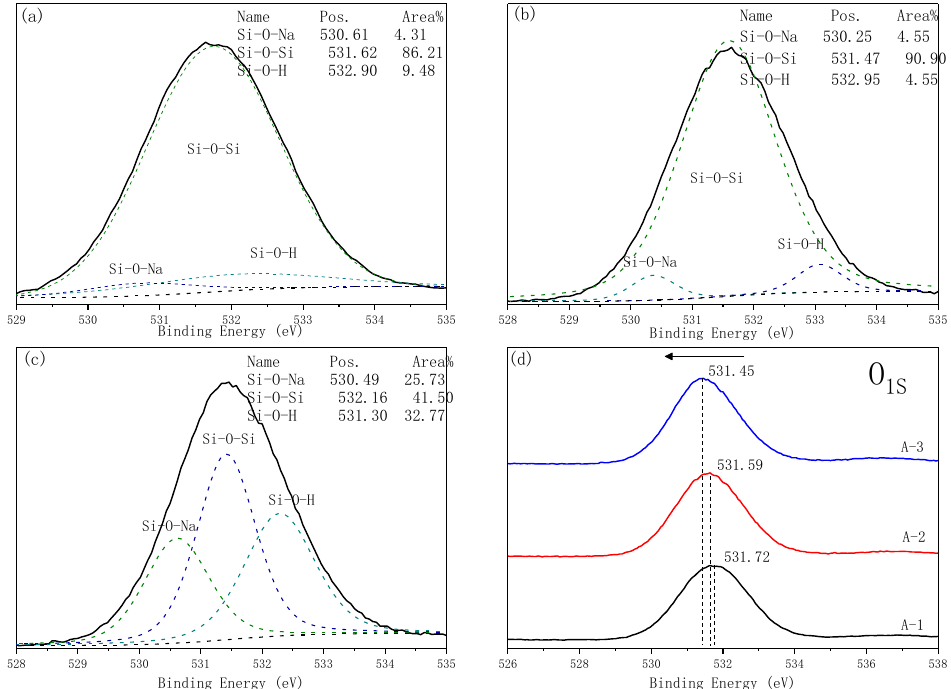
Figure 10. Fitting of O 1S line taken from: ( a ) A-1, ( b ) A-2, ( c ) A-3 and ( d ) all samples curing C-1 conditions.